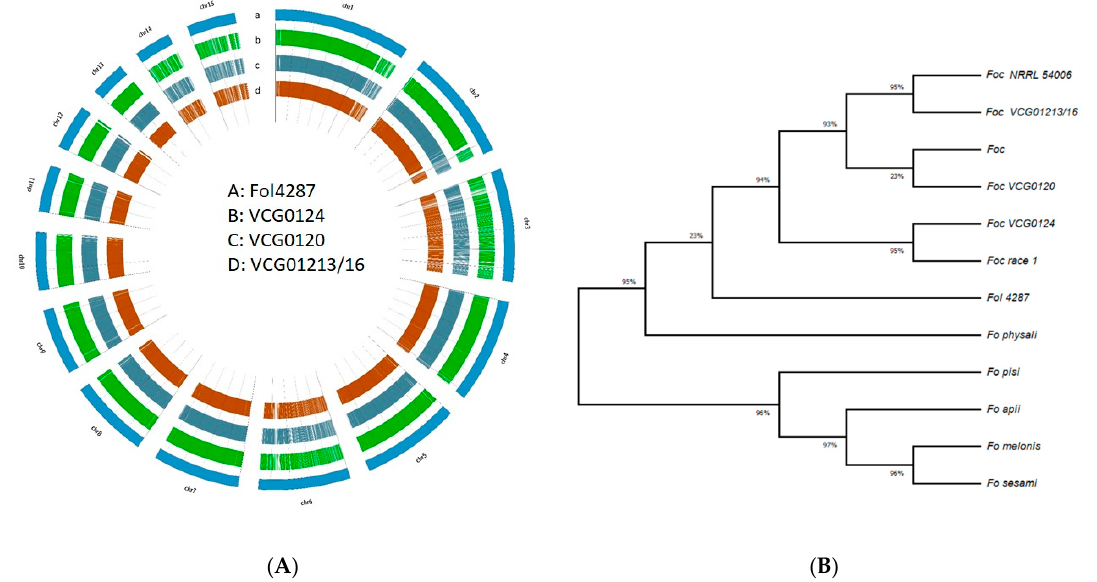
Figure 3. Whole-genome comparison of three Indian Foc races and phylogenetic analysis. ( A ) Whole-genome variations between Foc R1, Foc STR4 and Foc TR4 and reference Fol 4287, where a: Fol 4287; b–d: assembled Foc genome of R1, STR4 & TR4; and e: reference genome of Foc R1 (ASM593051v1). ( B ) Phylogenetic analysis of nine Fo strains from different f. sp resulting in two clustering clades, using MegaX 10.2.5 with the maximum-likelihood method.